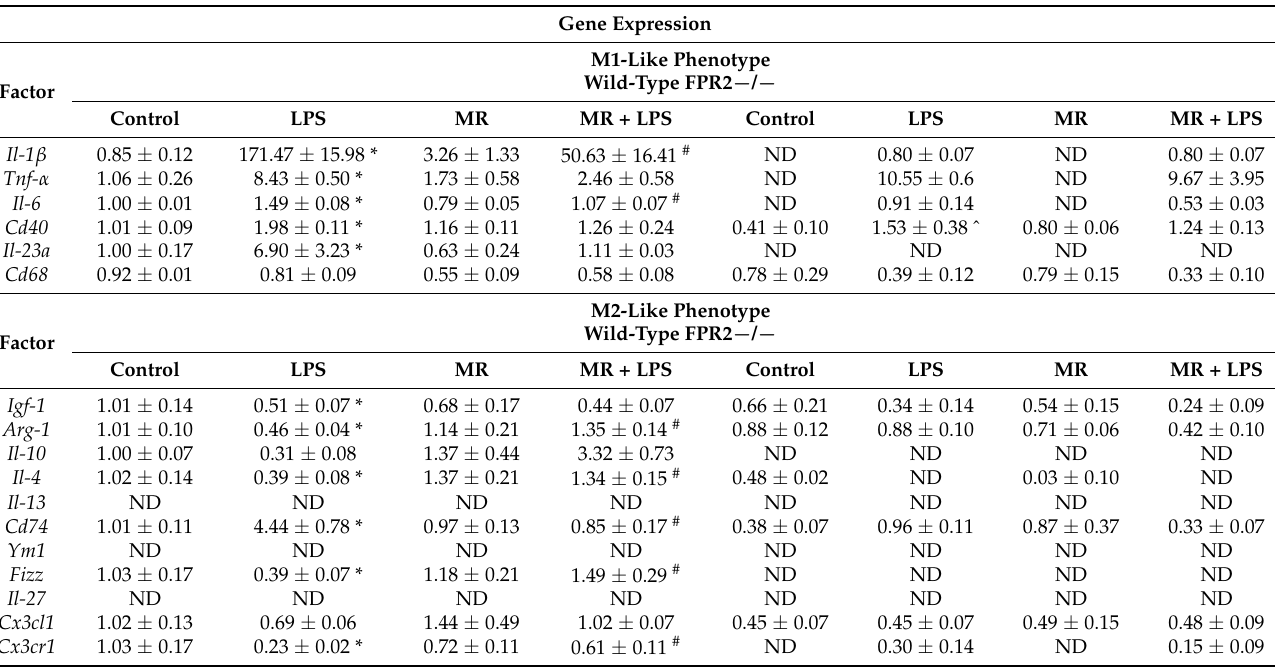
Table 2. The effects of LPS and/or MR-39, as well as WRW4, on mRNA expression in organotypic hippocampal cultures (OHCs) obtained from the offspring of wild-type (WT) and FPR2 − / − (KO) mice. OHCs obtained from WT and KO mice were pretreated with MR-39 (1 µ M) for 1 h and then stimulated with lipopolysaccharide (LPS; 1 µ g/mL) for 24 h. Control cultures were treated with the appropriate vehicle. The results are presented as average fold changes ± SEM. The data were obtained from three independent experiments. The results were statistically evaluated using a factorial analysis of variance (ANOVA) with Duncan’s post hoc test to assess the differences between the treatment groups. * Indicates significant differences in mRNA expression compared to control (vehicle-treated) WT OHCs. # Compared to WT OHCs stimulated with LPS. ˆ Compared to control (vehicle treated) KO OHCs. ND—Not